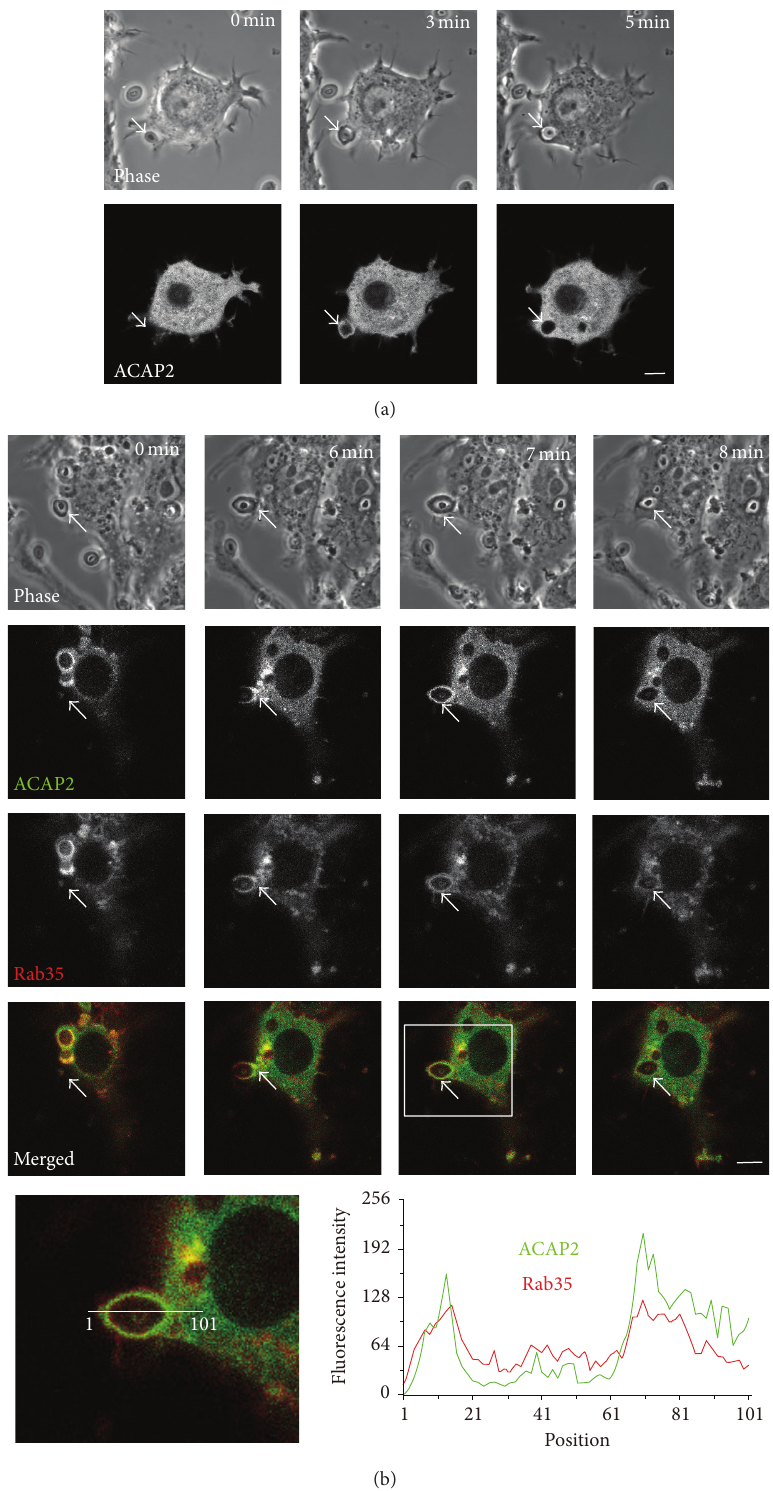
Figure 4: Live-cell imaging of GFP-ACAP2 and Rab35 in RAW264 macrophages during phagocytosis of zymosan. (a) RAW264 cells expressingGFP-ACAP2wereallowedtomakecontactwithzymosan(arrows)andwereobservedbyconfocallasermicroscopy.Phase-contrast images are shown (top panels). The elapsed time is indicated at the top. The binding of zymosan to the cell surface was set as time 0. Scale bar: 5 𝜇 m. (b) Live RAW264 macrophages coexpressing GFP-ACAP2 and TagRFP-Rab35 were incubated with zymosan and were monitored by confocal microscopy. Scale bar: 5 𝜇 m. Boxed area is enlarged (bottom left). Line scan analysis using MetaMorph program shows fluorescence intensities of GFP-ACAP2 (green) and TagRFP-Rab35 (red) at the position of the line in the enlarged